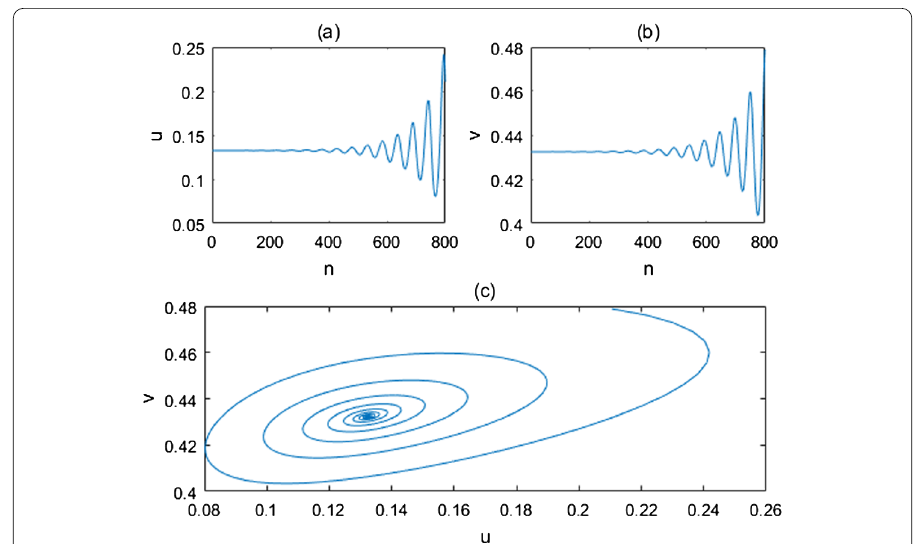
Figure 2 s = s 1 + 0.00000650778 is in a small neighborhood of s 1 = 0.09096349222. A repelling closed invariant curve bifurcates from the fixed point (0.13236426, 0.43236426) in the map (1.4) without control